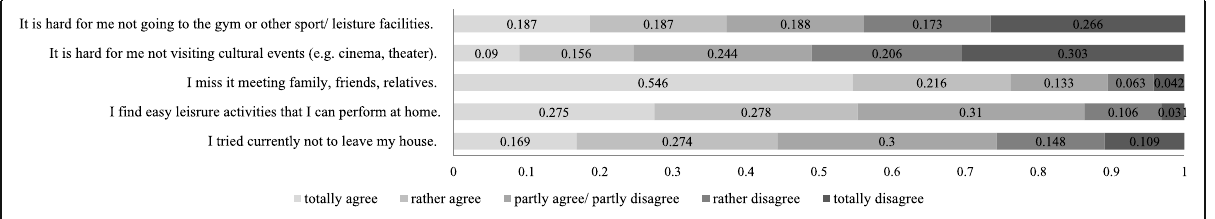
Fig. 6 Subjective evaluation of restrictions related to leisure activities and/ or daily